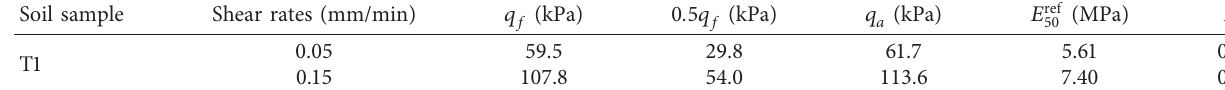
Table 4: Analytical results of partial parameters based on different shear rates in CU tests.